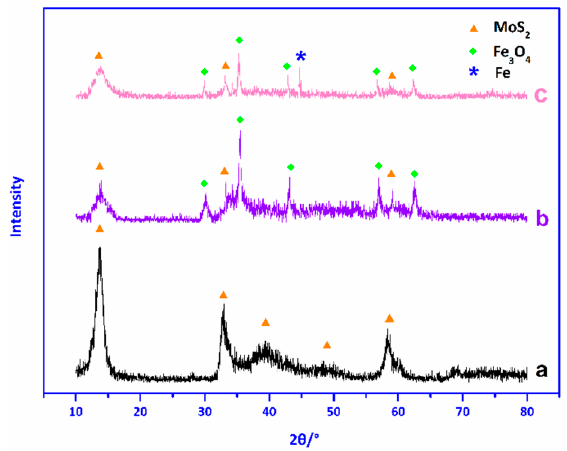
Figure 1. XRD patterns of ( a ) MoS 2 nanosheets (MNs), ( b ) MoS 2 /Fe 3 O 4 nanocomposite (MFN), ( c ) MoS 2 /Fe 3 O 4 /nZVI nanocomposites (MFNNs).